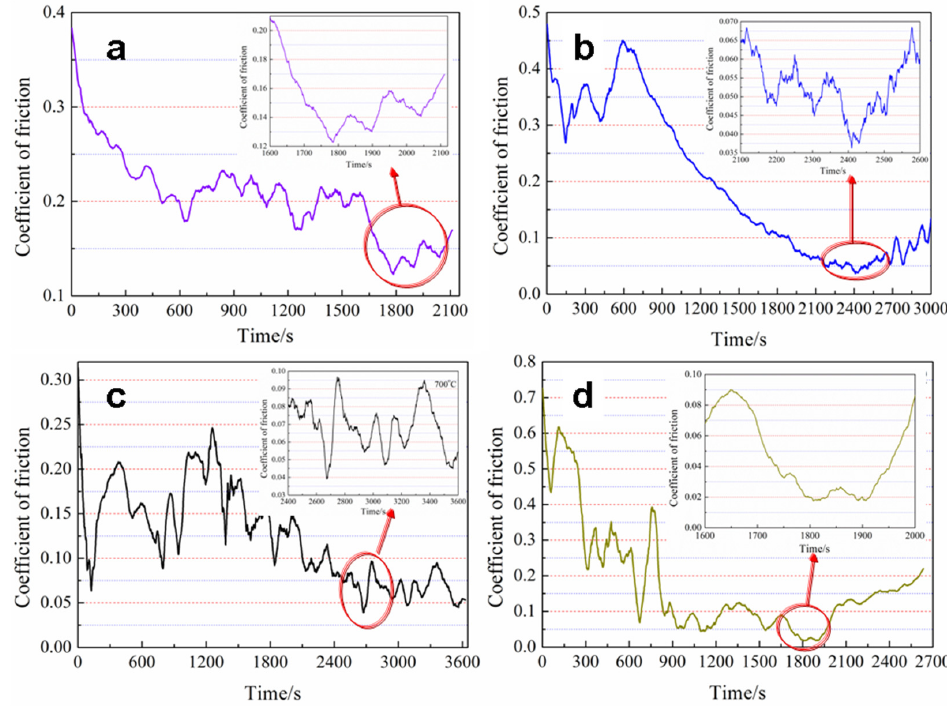
Figure 6. CoF of BN coatings under different temperatures in details: ( a ) 500 °C, ( b ) 600 °C, ( c ) 700 °C and ( d ) 800 °C.